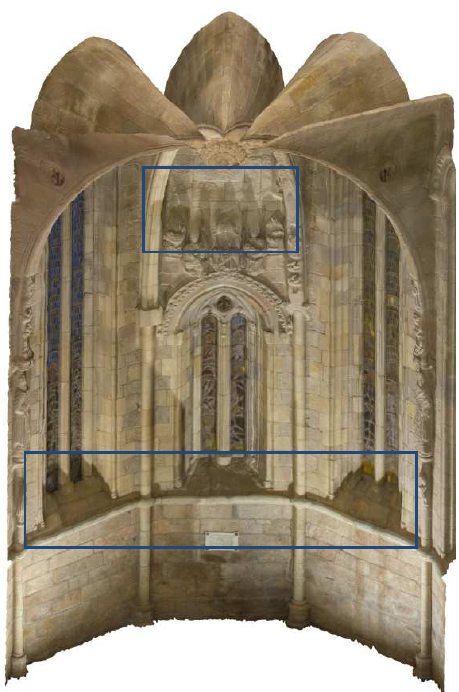
Figure 12. Shadows that could not be